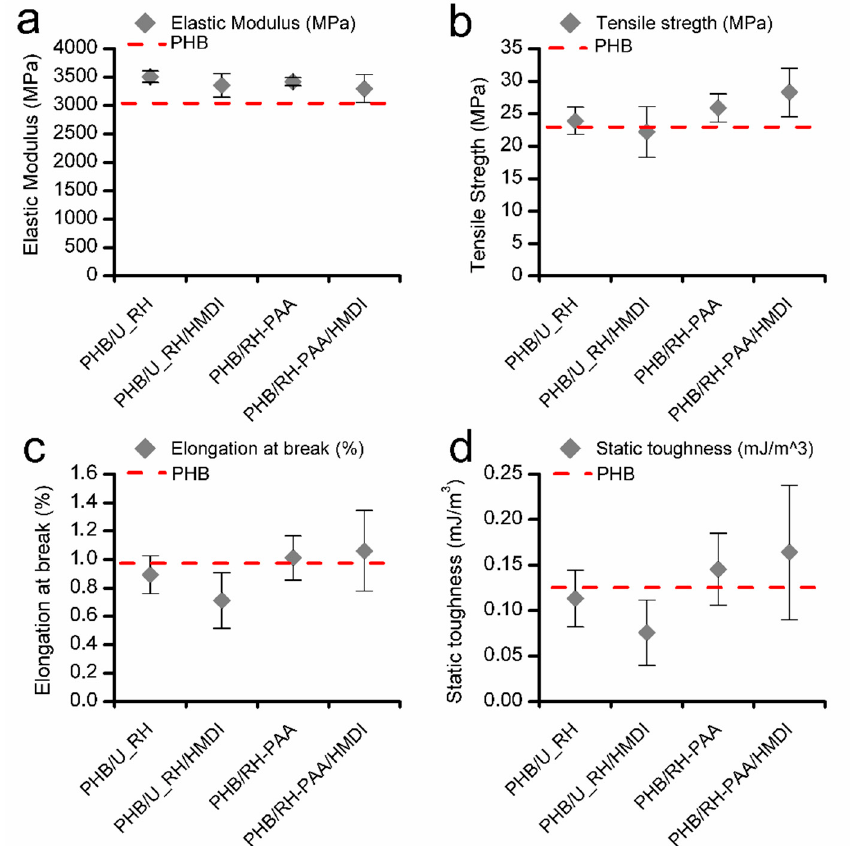
Figure 7. ( a ) Elastic modulus, ( b ) tensile strength, ( c ) elongation at break, and ( d ) static toughness of neat PHB, PHB/U_RH, and PHB/T_RH composites with and without reactive agents.